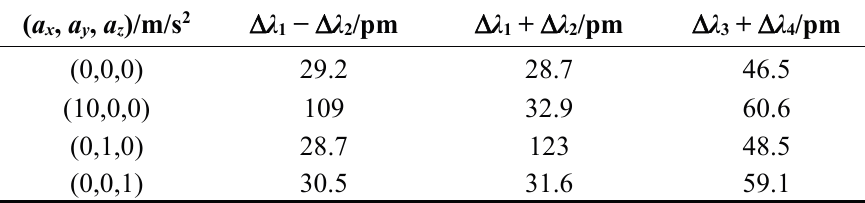
Table 2. Response of fiber Bragg grating (FBG) based triaxial sensor under different